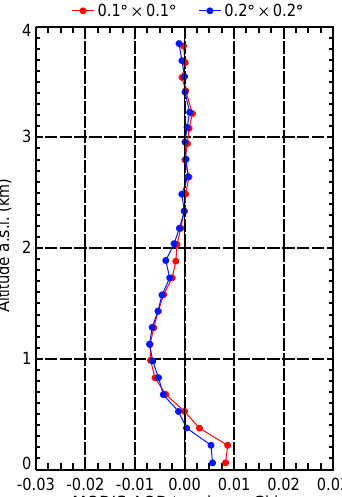
Figure 6. Vertical profiles of aerosol optical depth (AOD) trends over the entirety of China from gridded MODIS AOD data at 0.1 ◦ × 0.1 ◦ (red dots and red line) and 0.2 ◦ × 0.2 ◦ (blue dots and blue line) spatial resolutions from 2002 to